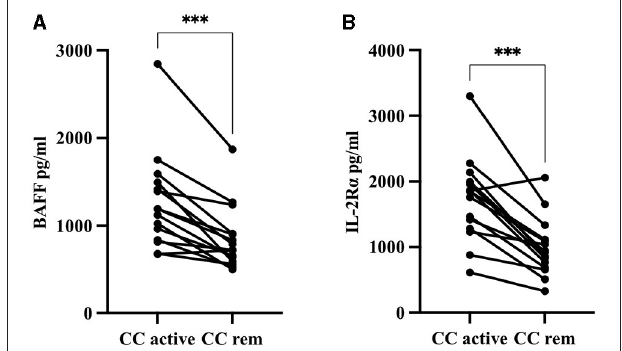
FIGURE 3 | Serum concentrations in pg/ml of (A) BAFF and (B) IL-2R α in 15 collagenous colitis (CC) patients with active disease compared to levels in the same patients after budesonide-induced remission. *** p <